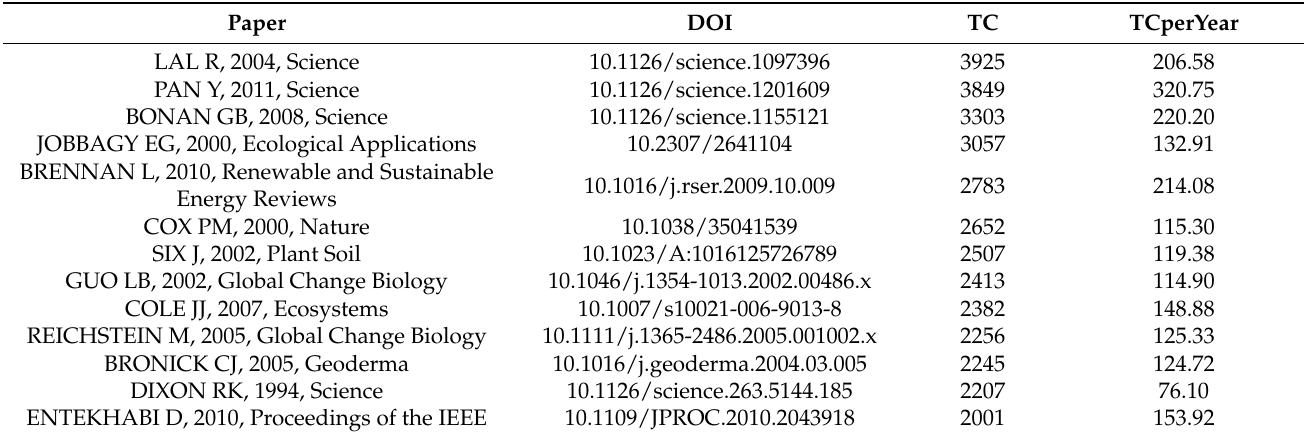
Table 2. Papers with more than 2000 Citations in the Field of the Impact of Land Use Change on Soil Carbon Sequestration from 1985 to 2021.